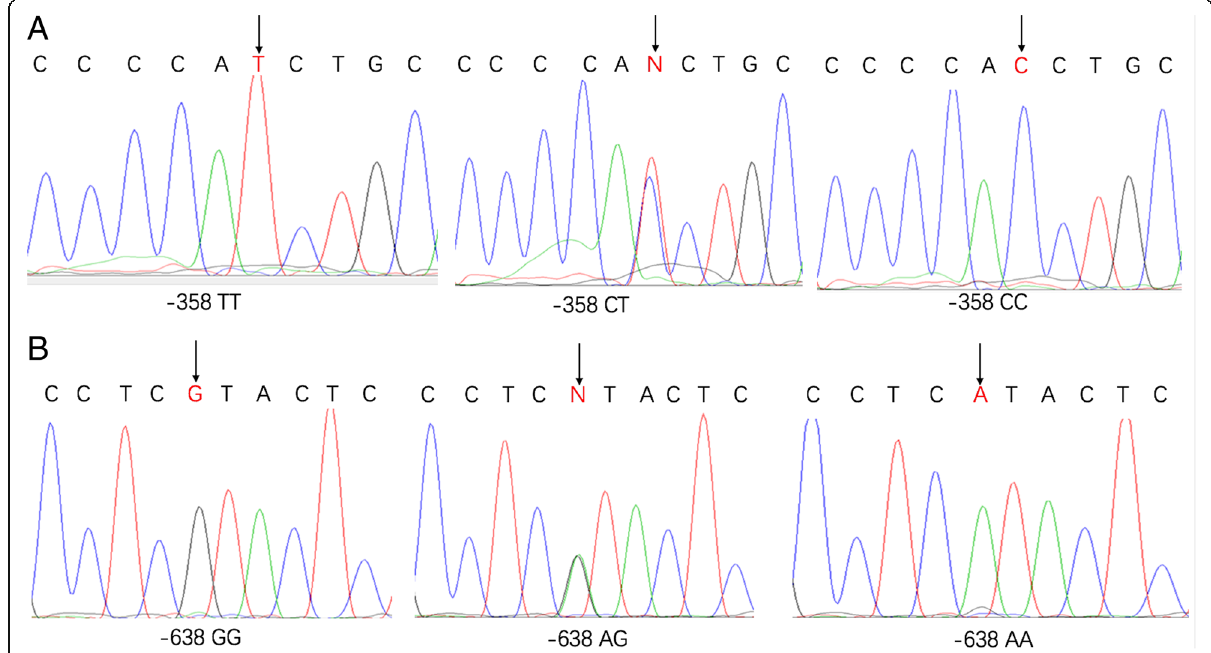
Fig. 1 Sequence analyses of the TNFSF15 promoter region reveal 2 SNPs located at nucleotides a − 638 A > G and b − 358 T > C. The arrows localize the base changes at the nucleotide